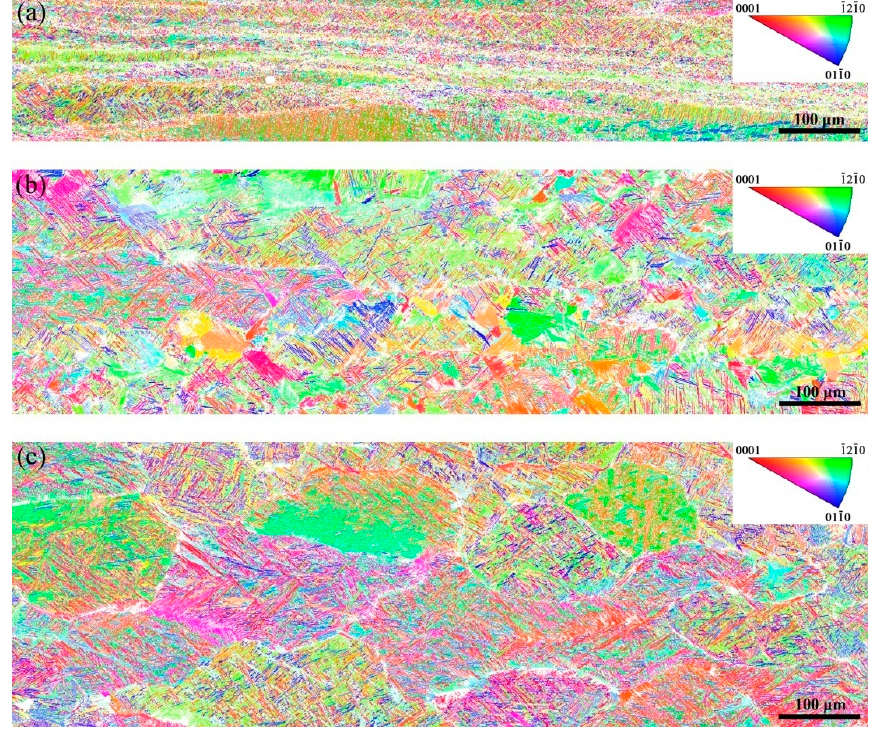
Figure 6. Inverse pole figure maps for the transformed α phase in the samples after deformation at ( a ) 2 s − 1 , ( b ) 0.2 s − 1 , and ( c ) 0.02 s − 1 . These maps are corresponding to those in Figure 2. The compression direction is vertical.